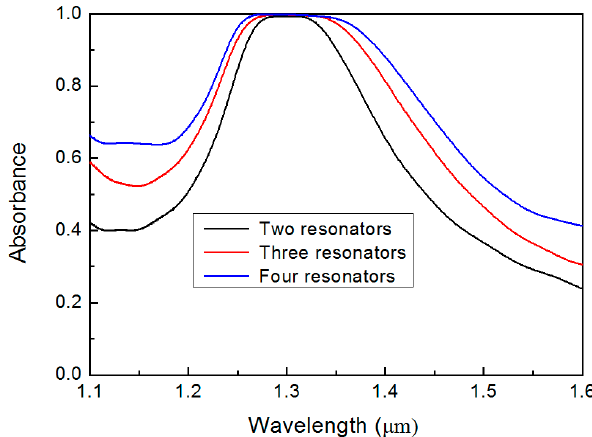
Figure 5. Numerically calculated absorbance spectra of the two (black line), three (red line), and four (blue line) coupled resonators in the unit cell of the proposed all-dielectric metasurface.